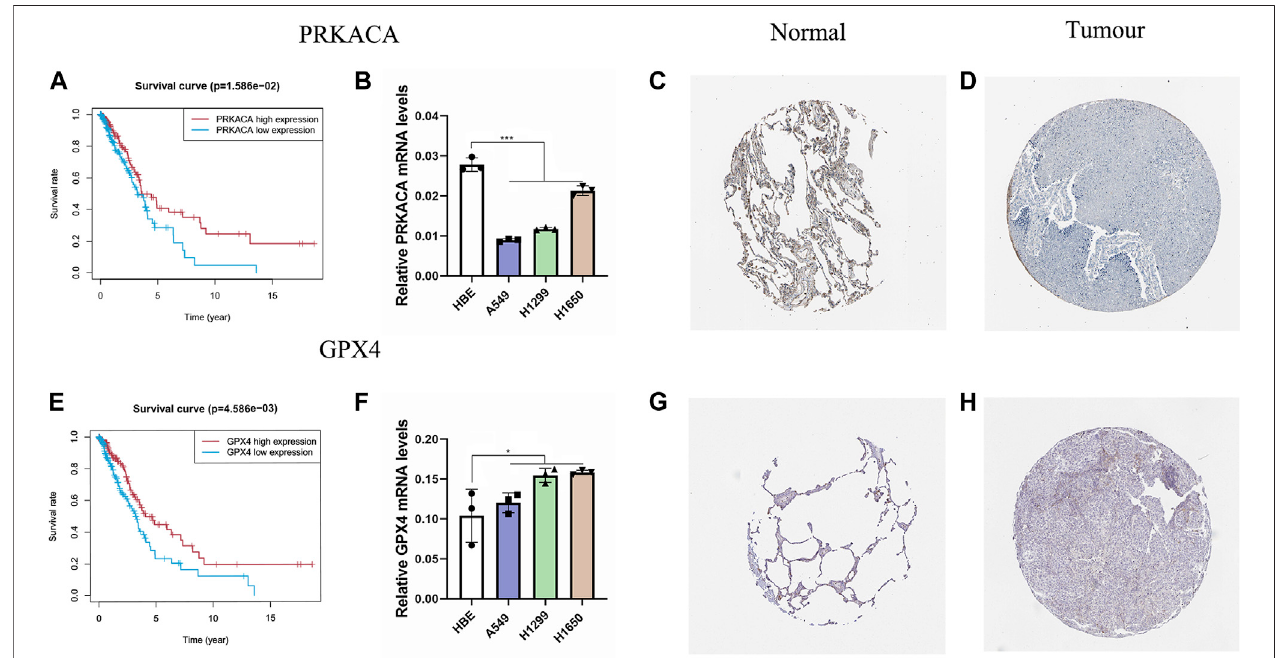
FIGURE 8 | Validation of PRKACA and GPX4. (A,E) The prognostic differences of PRKACA ( p = 1.586e-02) and GPX4 ( p = 4.586e-03) between the high-risk and low-risk groups were investigated. (B,F) Relative mRNA levels of PRKACA and GPX4 were displayed via qRT-PCR. PRKACA was highly expressed in normal tissues, and GPX4 showed the opposite. (C – D,G – H) Protein expression ofthe two candidate genes in the HPA database. (C – D) Protein expression of PRKACA. (G – H) Protein expression of